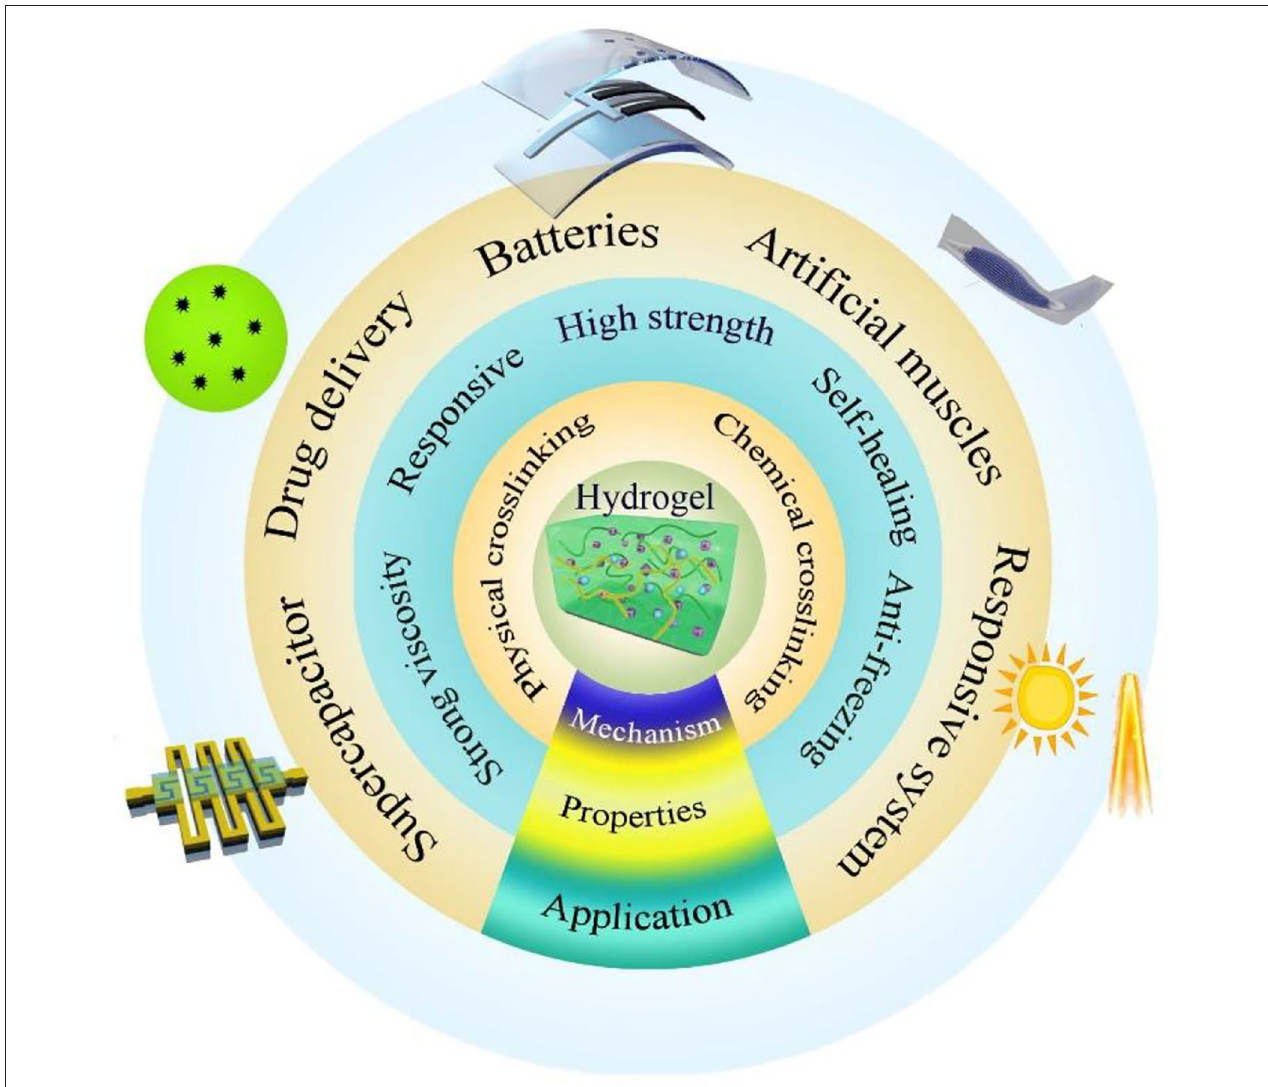
FIGURE 1 | Hydrogel in a wide range of